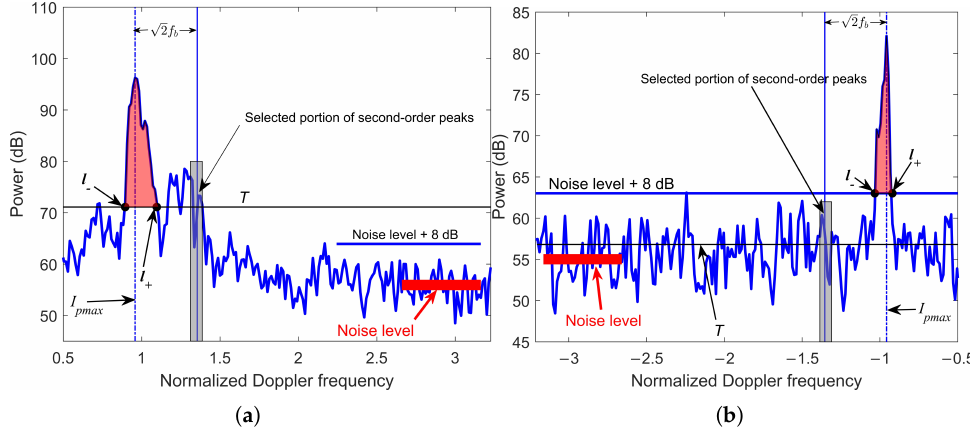
Figure 2. Demonstrates the first-order peaks determination for the second-order spectra-based (SSB) method. ( a ) a positive half Doppler spectrum case with prominent second-order spectra; ( b ) a negative half Doppler spectrum case without second-order spectrum. Apparently, in ( b ), the selected portion of second-order spectral points only contain noise, and without any second-order echo. T is the mean power of the selected portion of second-order spectral points, which are indicated by a light gray shadowing rectangle centering on the blue vertical line. The spectral points within the two black solid dots are the determined